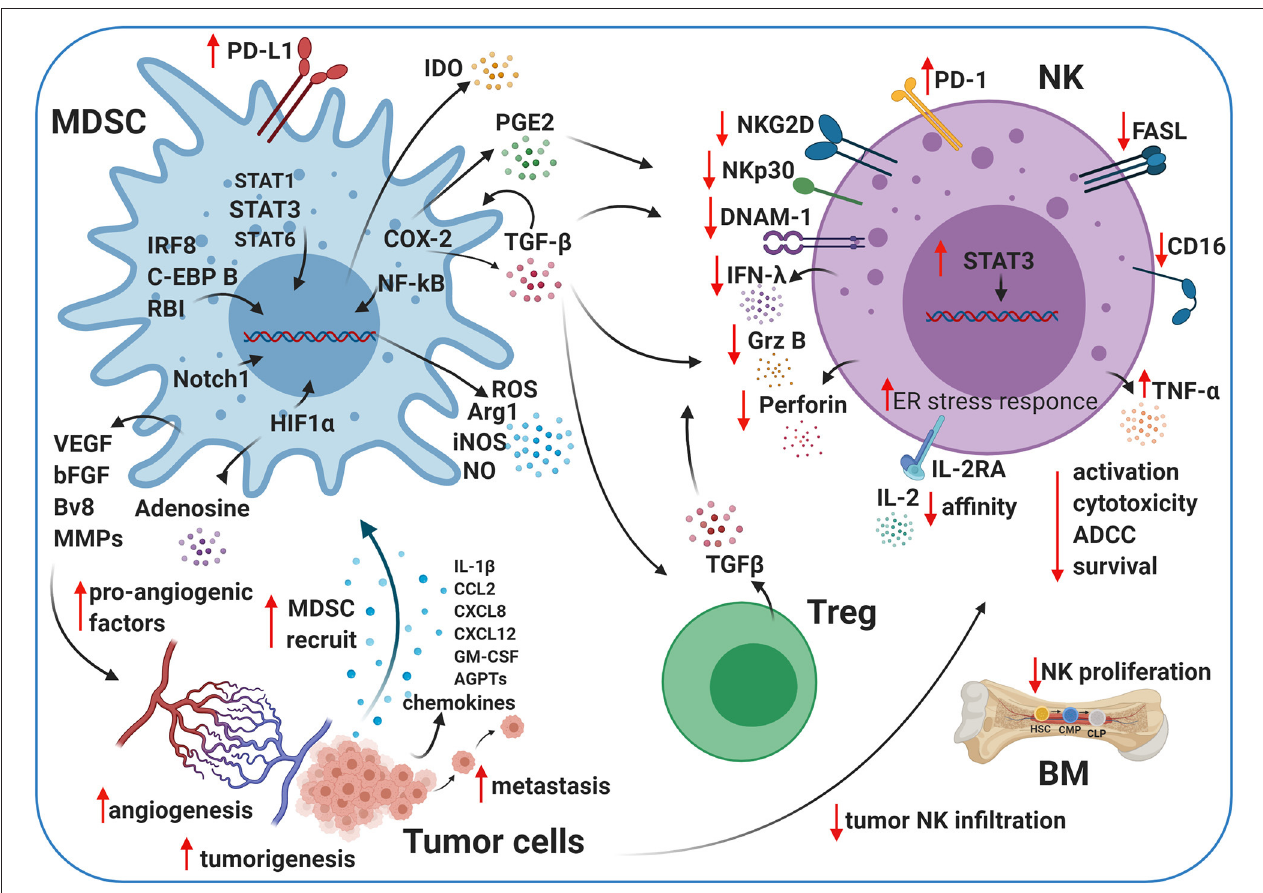
FIGURE 2 | Crosstalk between MDSCs, NK cells, and Tregs in the TME. Myeloid-derived suppressor cells (MDSCs) and natural killer (NK) cells crosstalk within the TME. The cartoon shows the immunosuppressive activity of MDSCs and regulatory T cells (Tregs) on NK cells using different pathways. MDSCs impair NK cell activation, cytotoxicity, survival, and maturation by several secreted factors, including transforming growth factor beta (TGF- β ), indoleamine 2,3-dioxygenase (IDO), nitrogen oxide (NO), reactive oxygen species (ROS), and prostaglandin-E2 (PGE2). MDSCs contribute to tumor angiogenesis by releasing pro-angiogenic factors, such as adenosine and vascular endothelial growth factor (VEGF), under pathological conditions. Created with